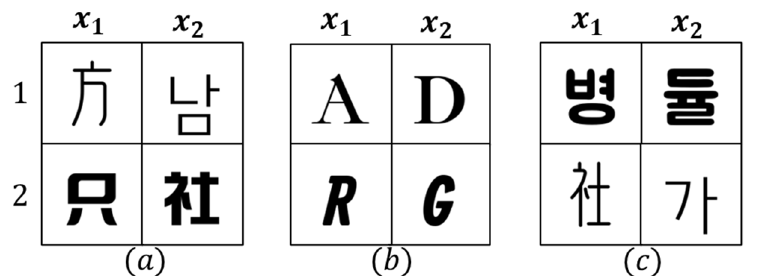
Figure 4. Example of Self-Supervised and Supervised Contrastive data loaders for ( a ) Chinese, ( b ) English, and ( c ) Korean font styles.